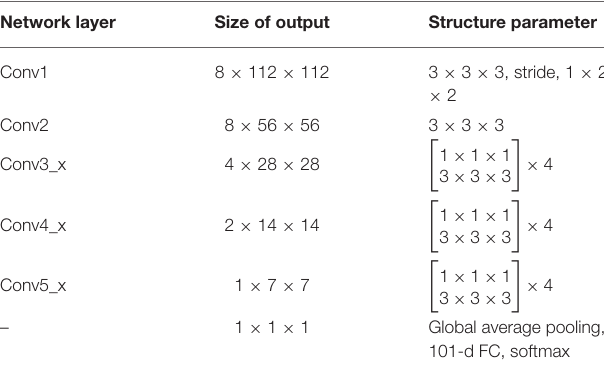
TABLE 1 | The parameters in 3D-MRDNet.